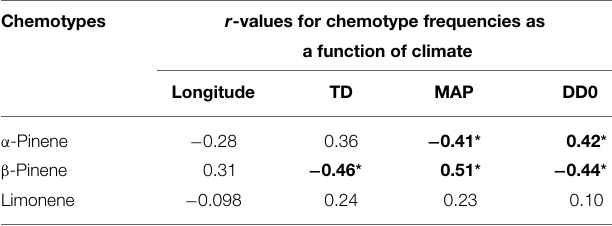
TABLE 3 | Pearson correlation coefficient values ( r ) between climatic variables and individual monoterpene concentrations in natural jack pine ( Pinus banksiana ) stands in eastern Canada and northeastern